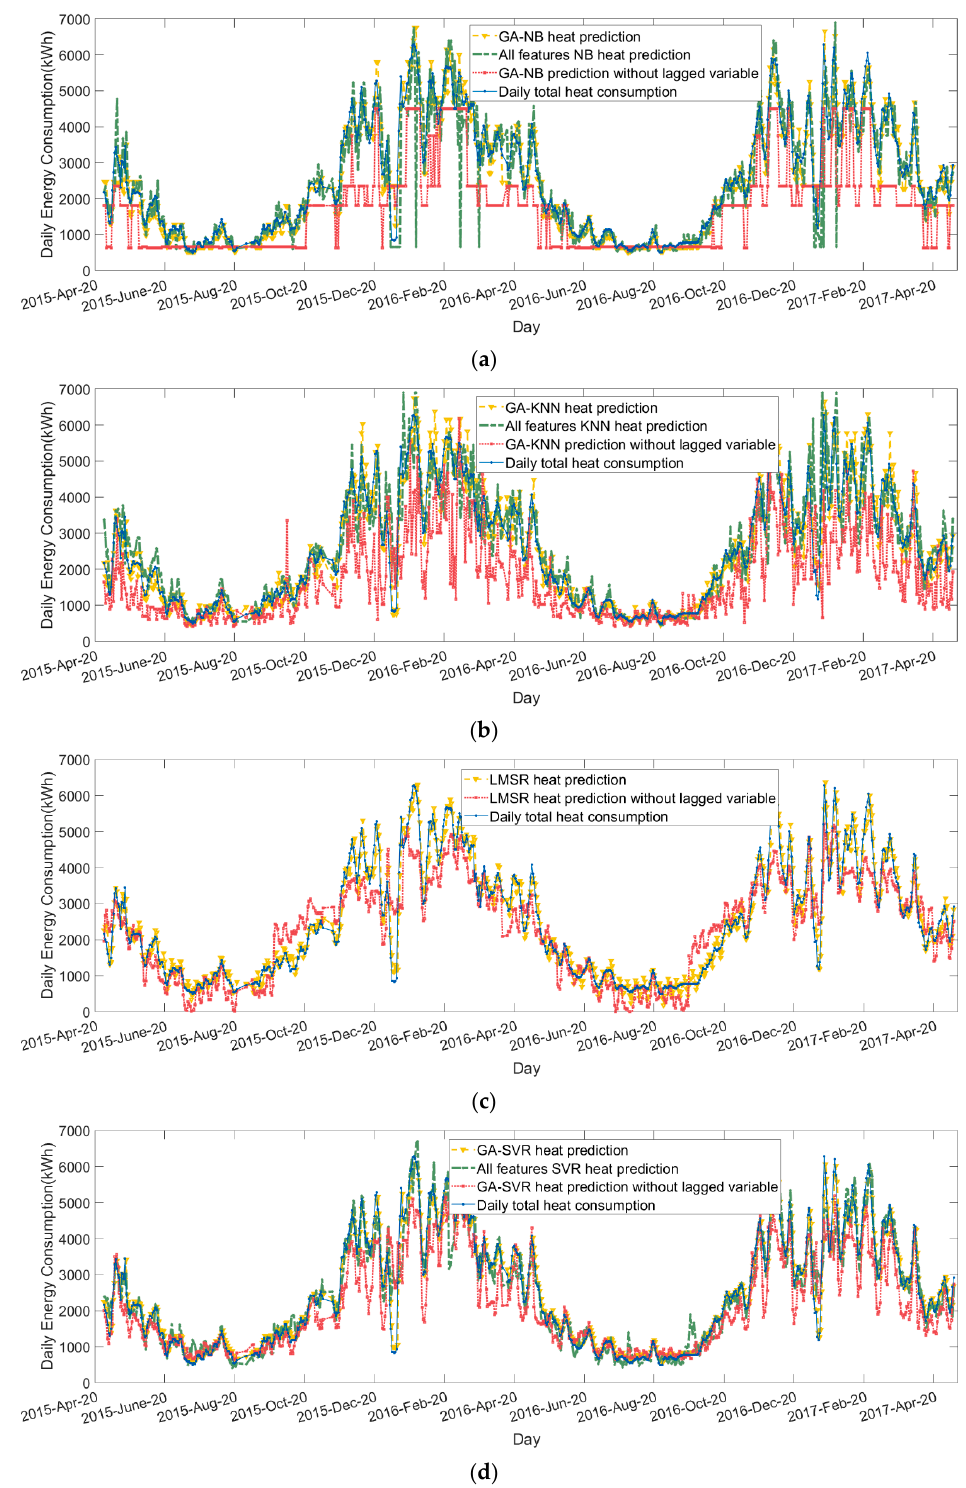
Figure 6. Machine learning (ML) modelled heat performance (Apr 2015–Apr 2017): ( a ) GA-NB heat model; ( b ) GA-KNN heat model; ( c ) LMSR heat model; and, ( d ) GA-SVR heat model.